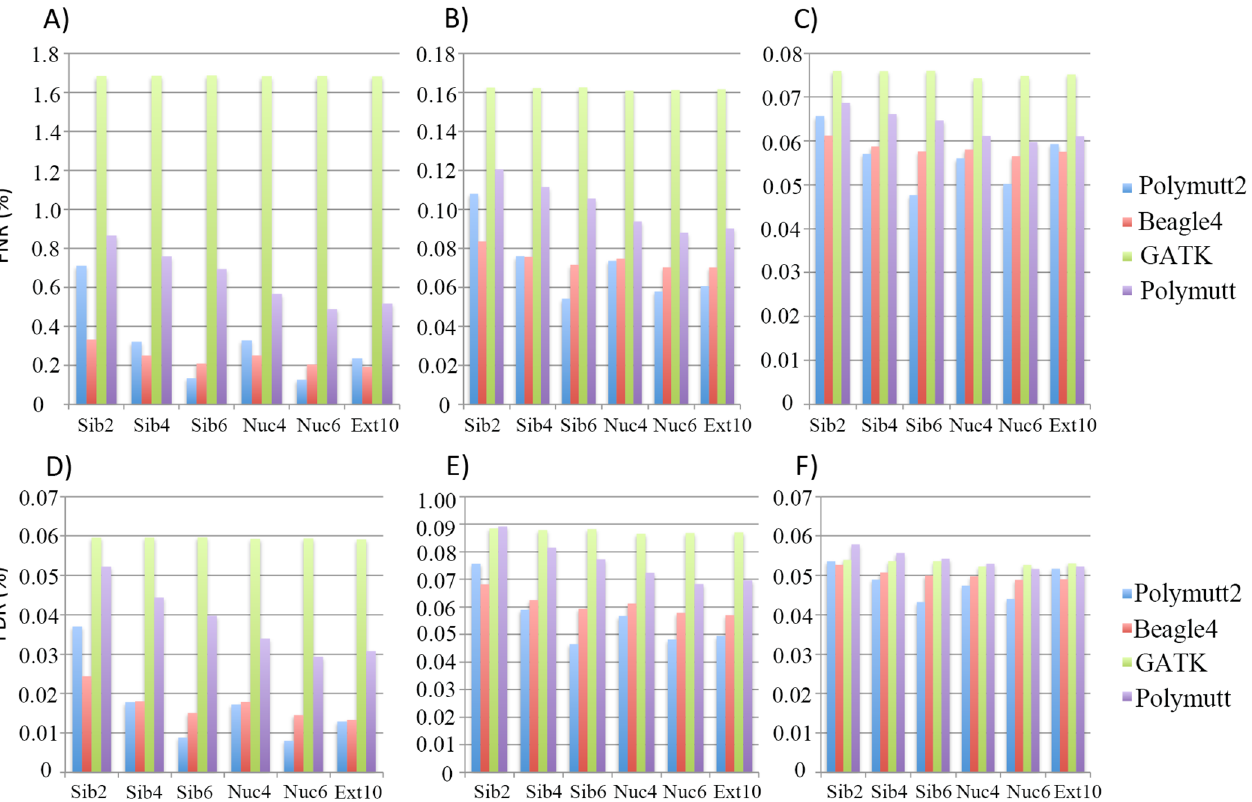
Fig 2. The FNR (%) (panel A, B and C) and FDR (%) (panel D, E and F) of the overall genotypes in 6 pedigrees from four callers (Polymutt2, Beagle4, GATK and Polymutt). Panels A, B and C show FNR (%) for sequencing coverage of 10X, 20X and 30X, and panels D, E and F show the FDR (%) for the same set of